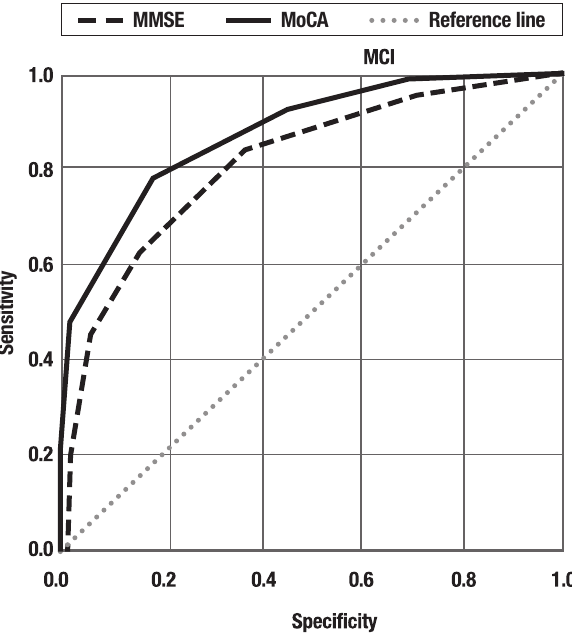
Figure 2. ROC curves for MMSE and MoCA tests for the detection of